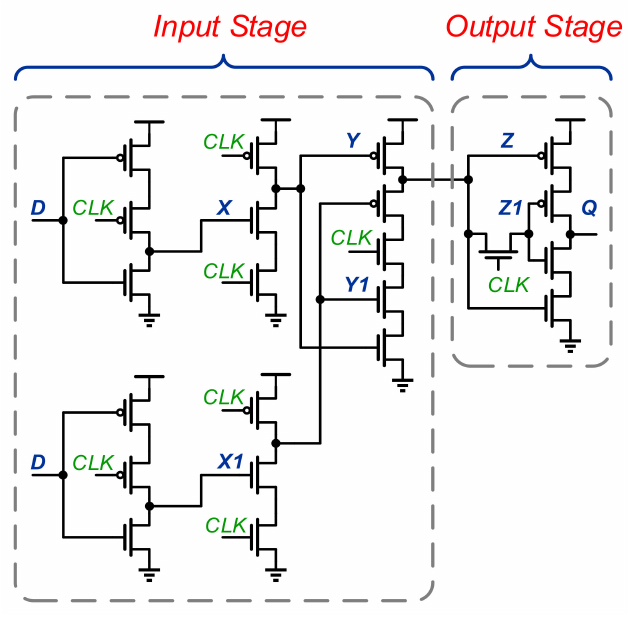
Figure 10. Schematic diagram of DM-TSPC.